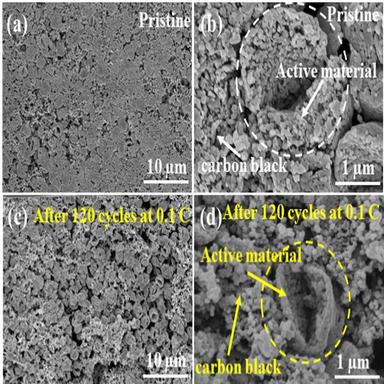
Ex situ SEM images of the walnut-shell-like NaNCMA-3 electrode (a, b) before and (c, d) after 100 cycles at 0.1C.